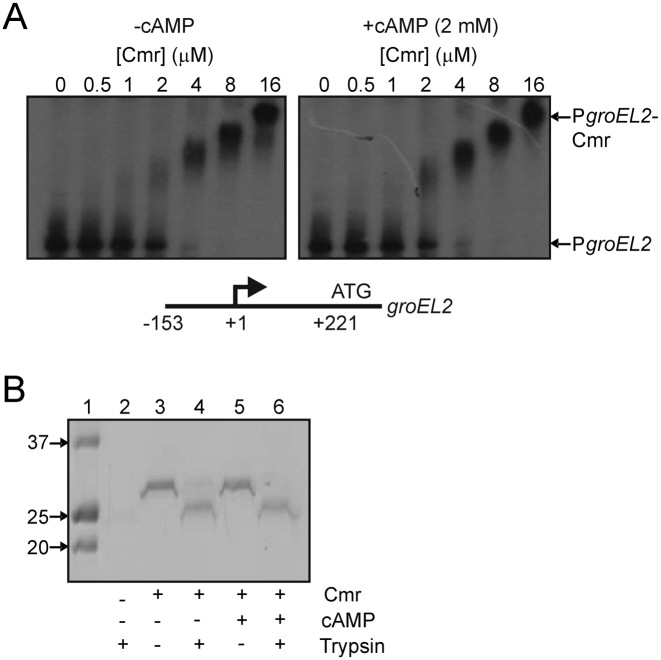
Cmr binding at the groEL2 promoter (PgroEL2) is independent of cAMP and Cmr does not bind cAMP. (A) Radiolabelled PgroEL2 (amplified from p2126, Supplementary Table S1) was incubated with increasing concentrations of Cmr, with or without cAMP (2 mM final concentration) as indicated, before separation of protein-DNA complexes (PgroEL2-Cmr) from free DNA (PgroEL2) by electrophoresis. The final concentration of Cmr dimer in the assays is indicated above each lane. A diagram (not to scale) showing features (arrow, transcript start; ATG, groEL2 translational start) of the DNA used in the EMSAs is shown below the autoradiographs. (B) Partial proteolysis of Cmr in the presence and absence of a 10-fold molar excess of cAMP. Lane 1, Precision Plus Protein Standards (BioRad) with molecular weights in kDa indicated; Lanes 2–6, reaction components are as indicated below the image of the gel.